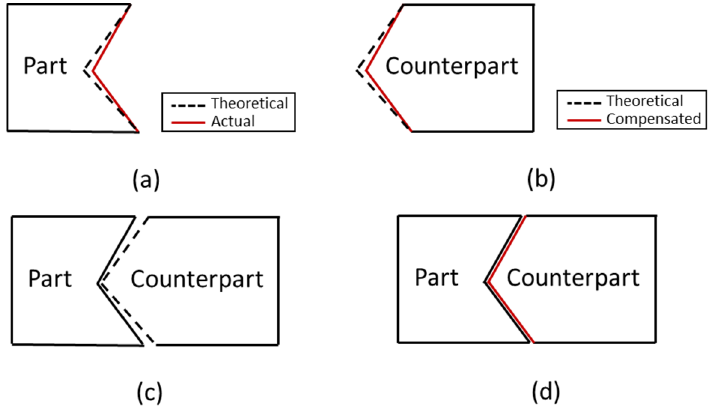
Figure 6. ( a ) Part shape, ( b ) counterpart shape, ( c ) assembly matching without compensation, ( d ) assembly matching with compensation.